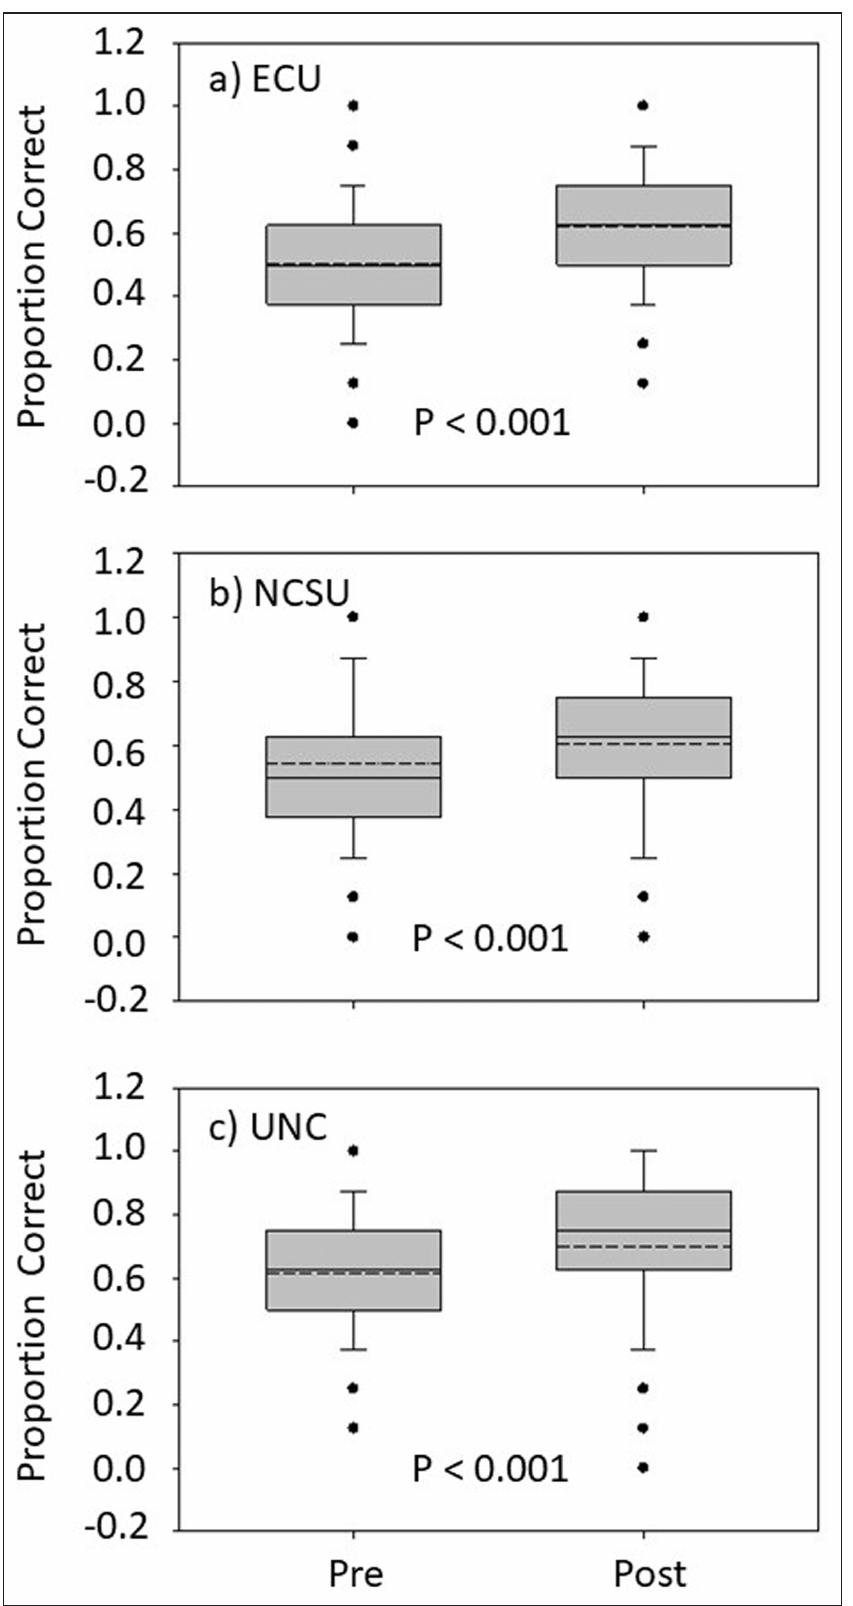
Figure 1 Box plots depicting the pre- and post-scores of student content knowledge and science literacy for each institution separately (a = East Carolina University [ECU], b = North Carolina State University [NCSU], c = University of North Carolina Chapel Hill [UNC]). Medians are shown with a solid line and the means are shown with a dotted